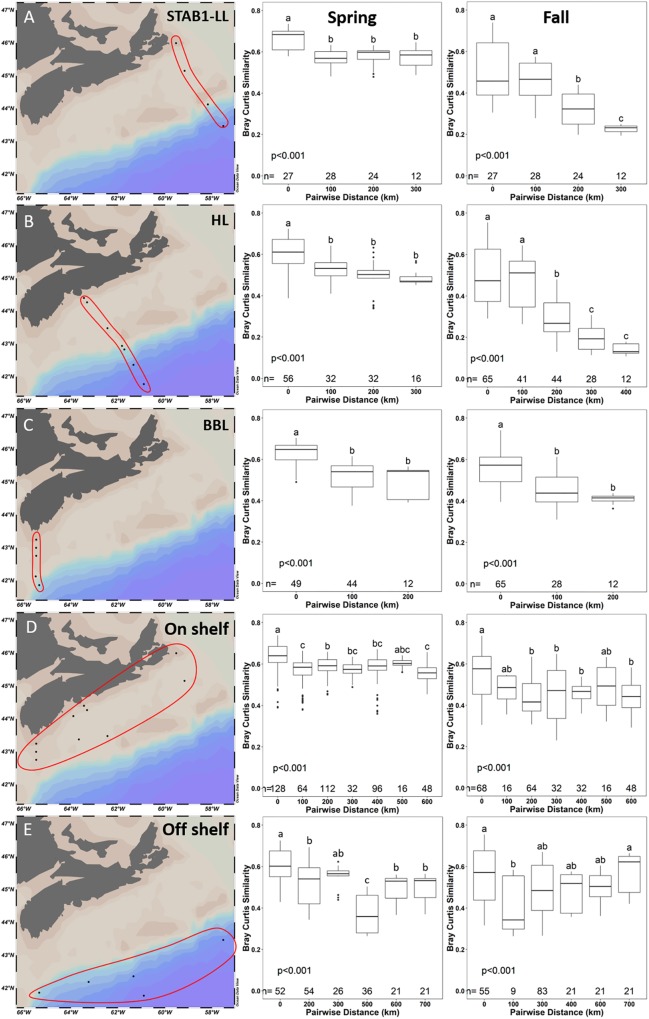
Pairwise comparisons of Bray–Curtis similarity between samples in 100 km bins along 2014 cross-shelf transects (A–C: STAB1-LL, HL, and BBL, respectively) and from near- and offshore samples (D,E, respectively). Significance between distance bins was tested by ANOVA with post hoc testing by Tukey tests (α = 0.05). Bins not sharing a letter are significantly different. The numbers (n=) at the bottom of the graphs represent the number of samples that were compared at each distance stated on the x-axis. Samples from 1 to 100 m depth were used.